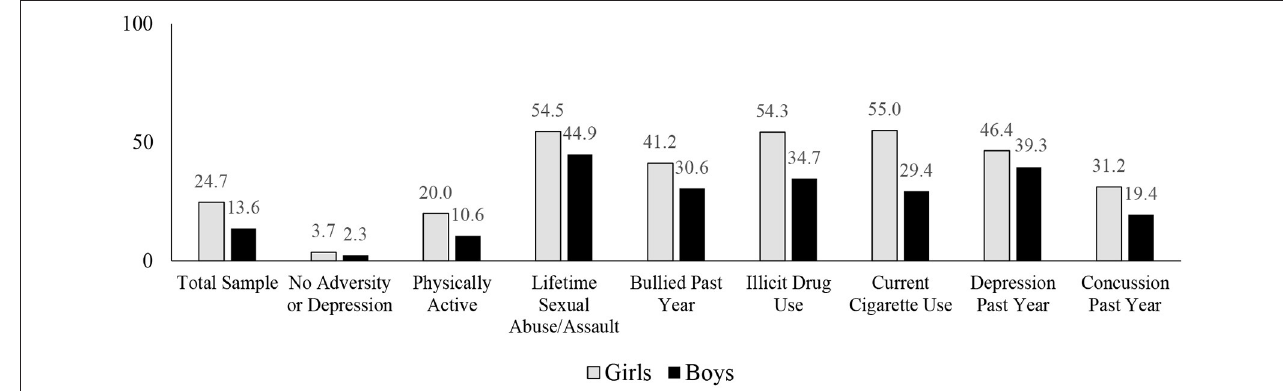
FIGURE 1 | Percentages of high school students endorsing suicidal ideation over the past year. See Table 1 for the definitions of the variables. See Table 2 for the sample sizes. The no adversity or depression group responded “no” to all of the questions relating to sexual abuse or assault, feeling unsafe at school, being bullied, and being depressed in the past year. The physically active group reported being active for 60min or more for at least 5 of the past 7 days. The illicit drug use groups reported a lifetime history of using drugs 3 or more